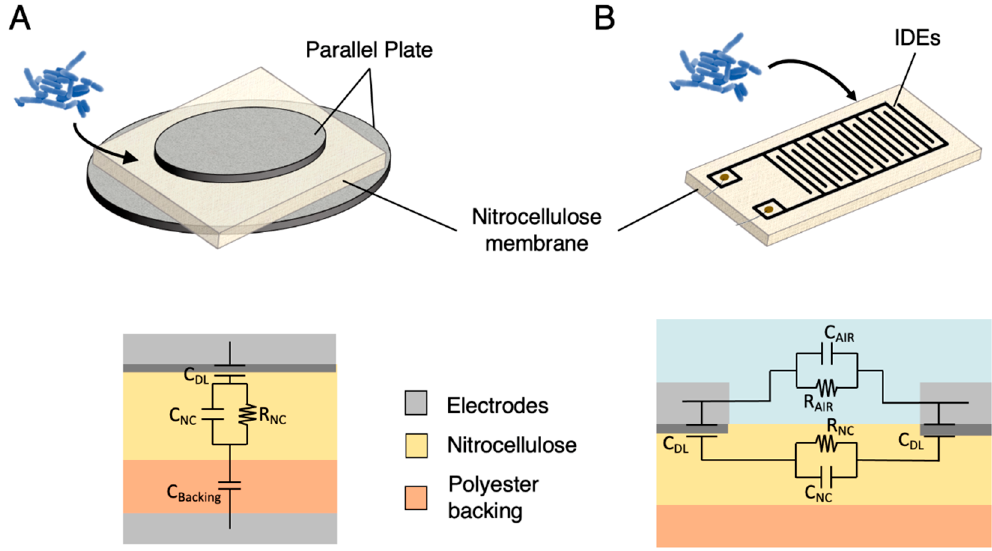
Figure 2. Experimental setups and corresponding electrical models investigated towards bacteria detection in this work. ( A ) Parallel-plate probes are a common material dielectric measurement system. The bacterial sample is deposited on the NC membrane and conducted to the test zone by capillarity. A simple electrical model is proposed to consider the dielectric effect of the polyester backing supporting the NC and the electrical double layer that arises from charge redistribution at the interface between the electrolyte and the probe. ( B ) Interdigital electrodes are generally used as sensors to monitor impedance changes at the proximity of the metallic fingers, here deposited on NC membrane. The bacterial samples are deposited on top of the interdigital electrode (IDE)-NC sensor. The model does not include the polyester backing as its impact on the impedance seen by the IDE is negligible due to its depth.